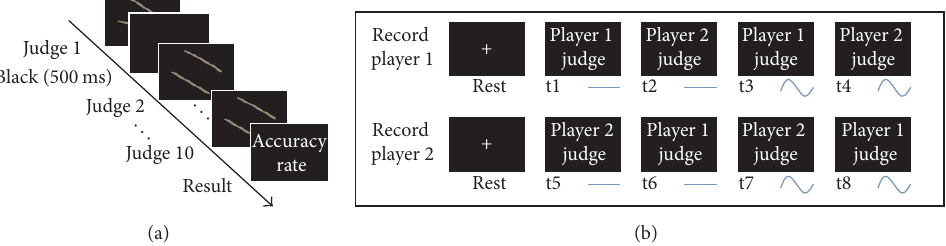
Figure 2: The process of experiment. (a) A complete process of one trial. (b) Full process of the experiment, including 8 task-trials and two